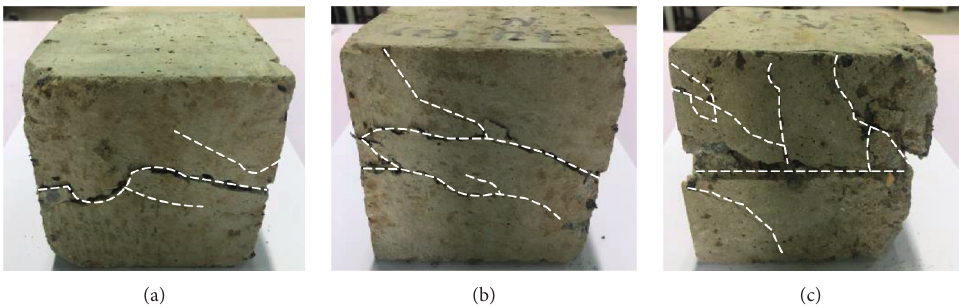
Figure 3: The influence of axial compression ratio on the shear failure mode of rubber fiber concrete. (a) 0% f f c A s .